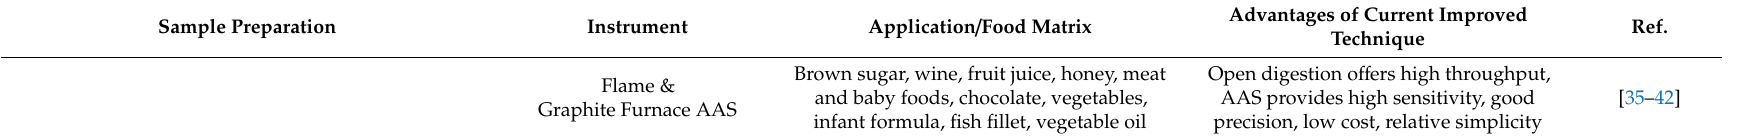
Table 2. Methods, food matrices and advantages of current improved technique for